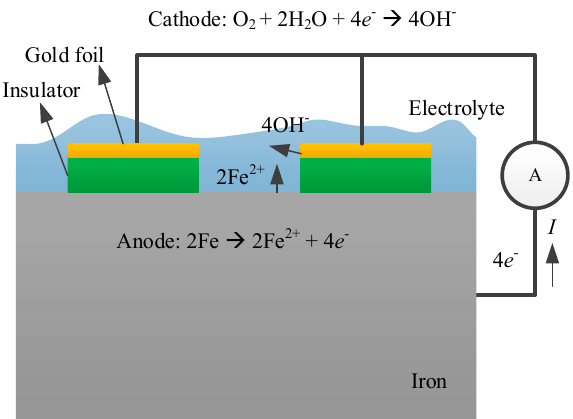
Figure 1. Schematic galvanic corrosion of a Fe-Au cell.